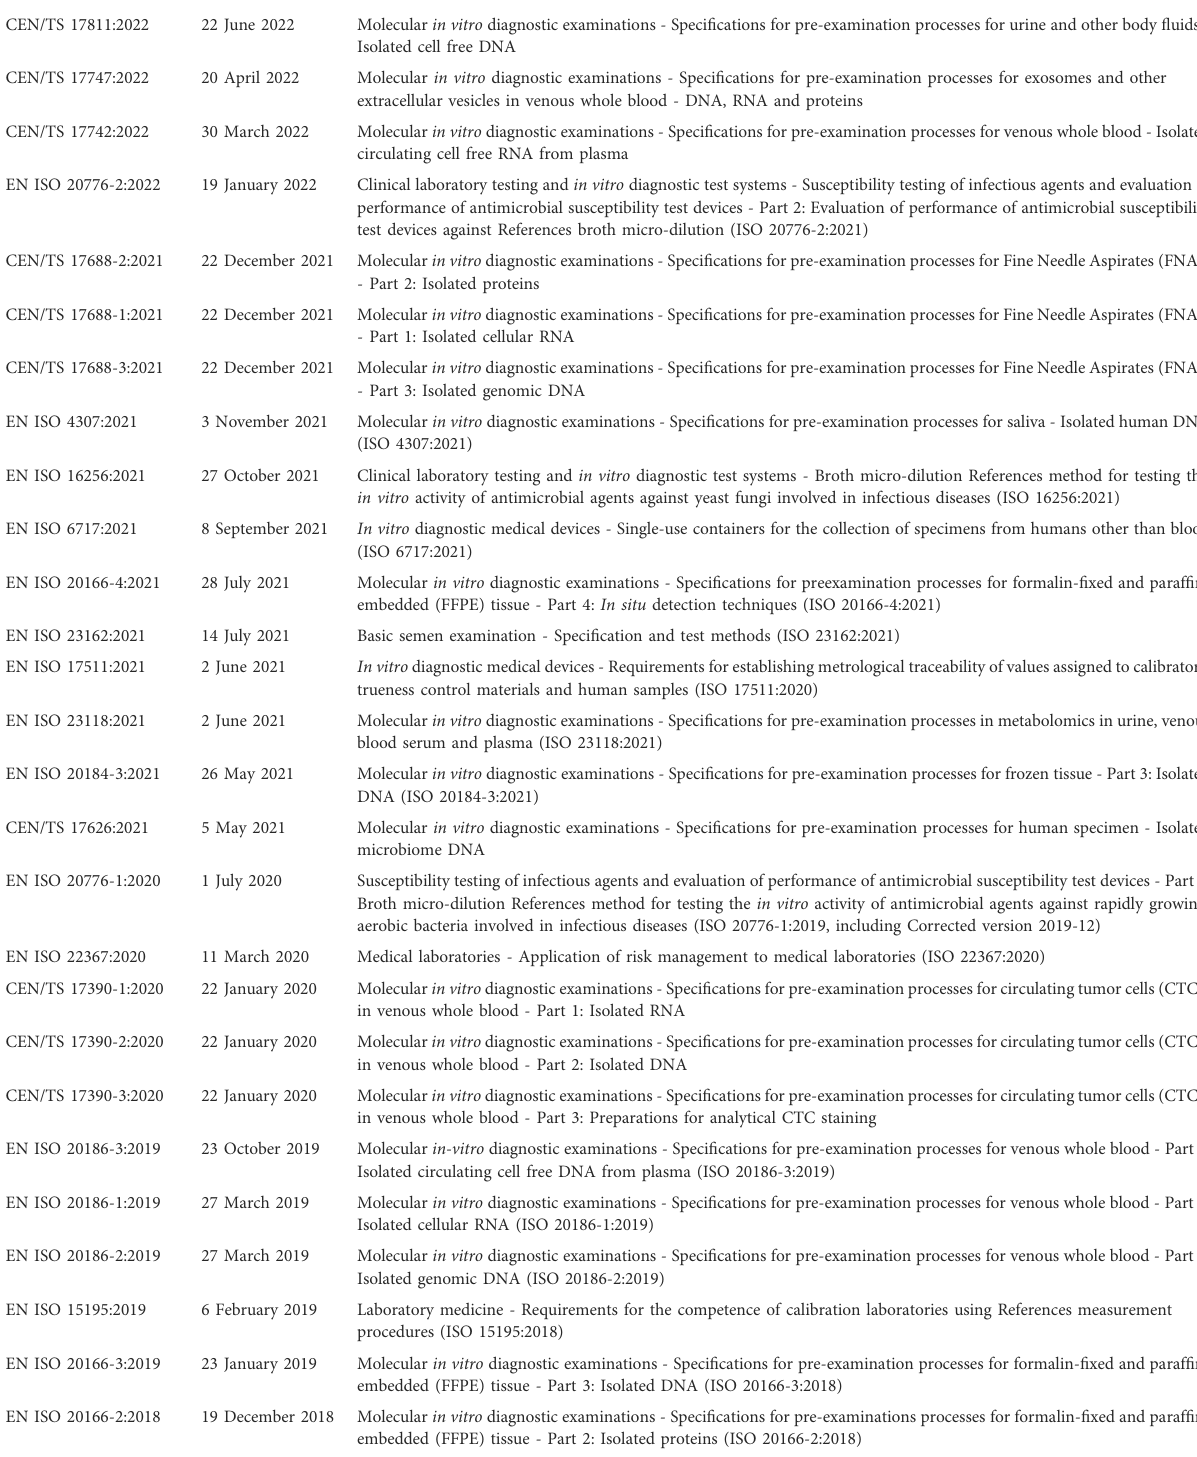
TABLE 5 European Committee for Standardization Technical Committee (CEN/TC) 140 in vitro diagnostic medical devices published standards. All projects are sorted by date and available at https://www.spidia.eu/projects/standard-documents (Accessed 28 July